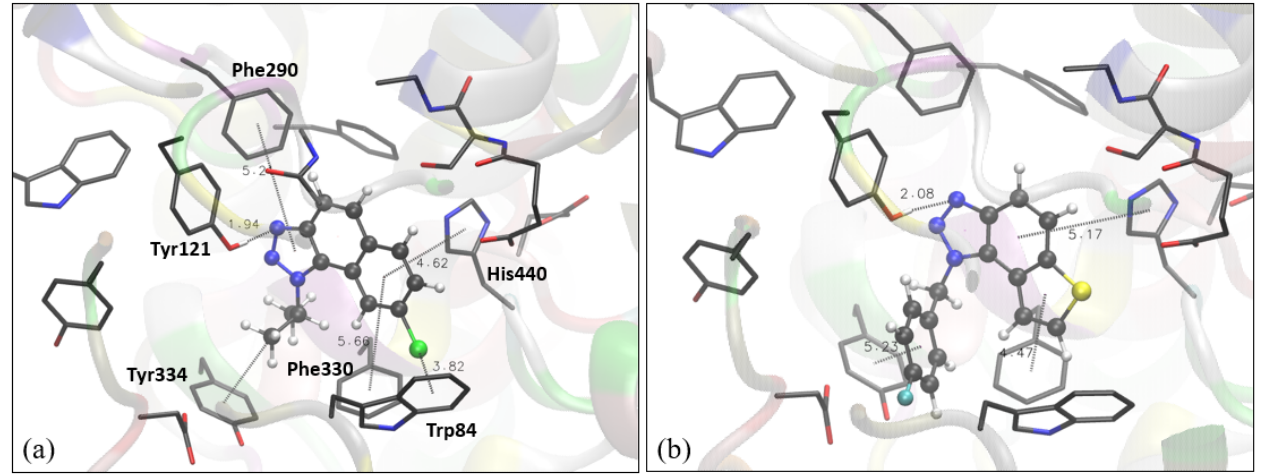
Figure 3. Structure of the active site of AChE docked with naphtho-triazole 1 ( a ) and thienobenzo- triazole 4 ( b ). Molecules of the potential inhibitors are presented using a ball-and-stick model.